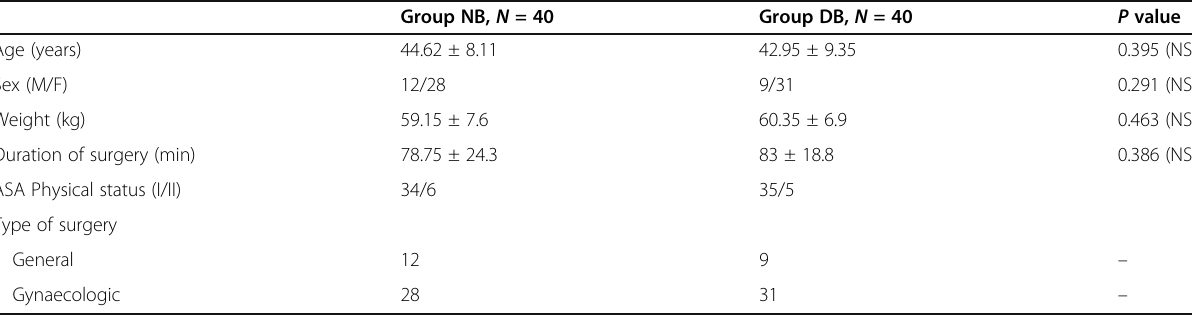
Table 1 Demographic profile